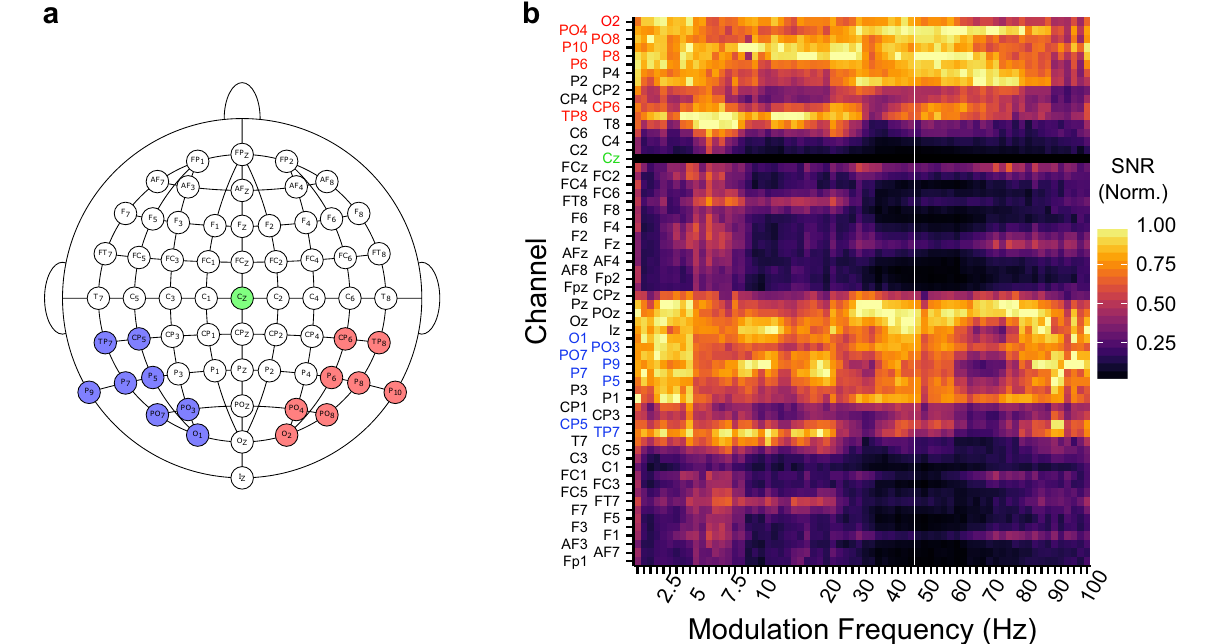
Figure 1. Electrode configuration and response strength across the scalp. ( a ) The electrodes that were combined into the left (in blue) and right (in red) hemispheric channel, and the reference electrode Cz (in green). ( b ) The average SNR (linear) normalized to the maximum value per modulation frequency in function of modulation frequency and recording channel. A SNR (Norm.) of 1 represents the recording electrodes with the highest SNR for a particular modulation frequency whereas a 0 indicates the recording electrodes with the lowest SNR. The results in panel B show that the recording electrodes that were used in the analyses were those with the highest SNR across modulation